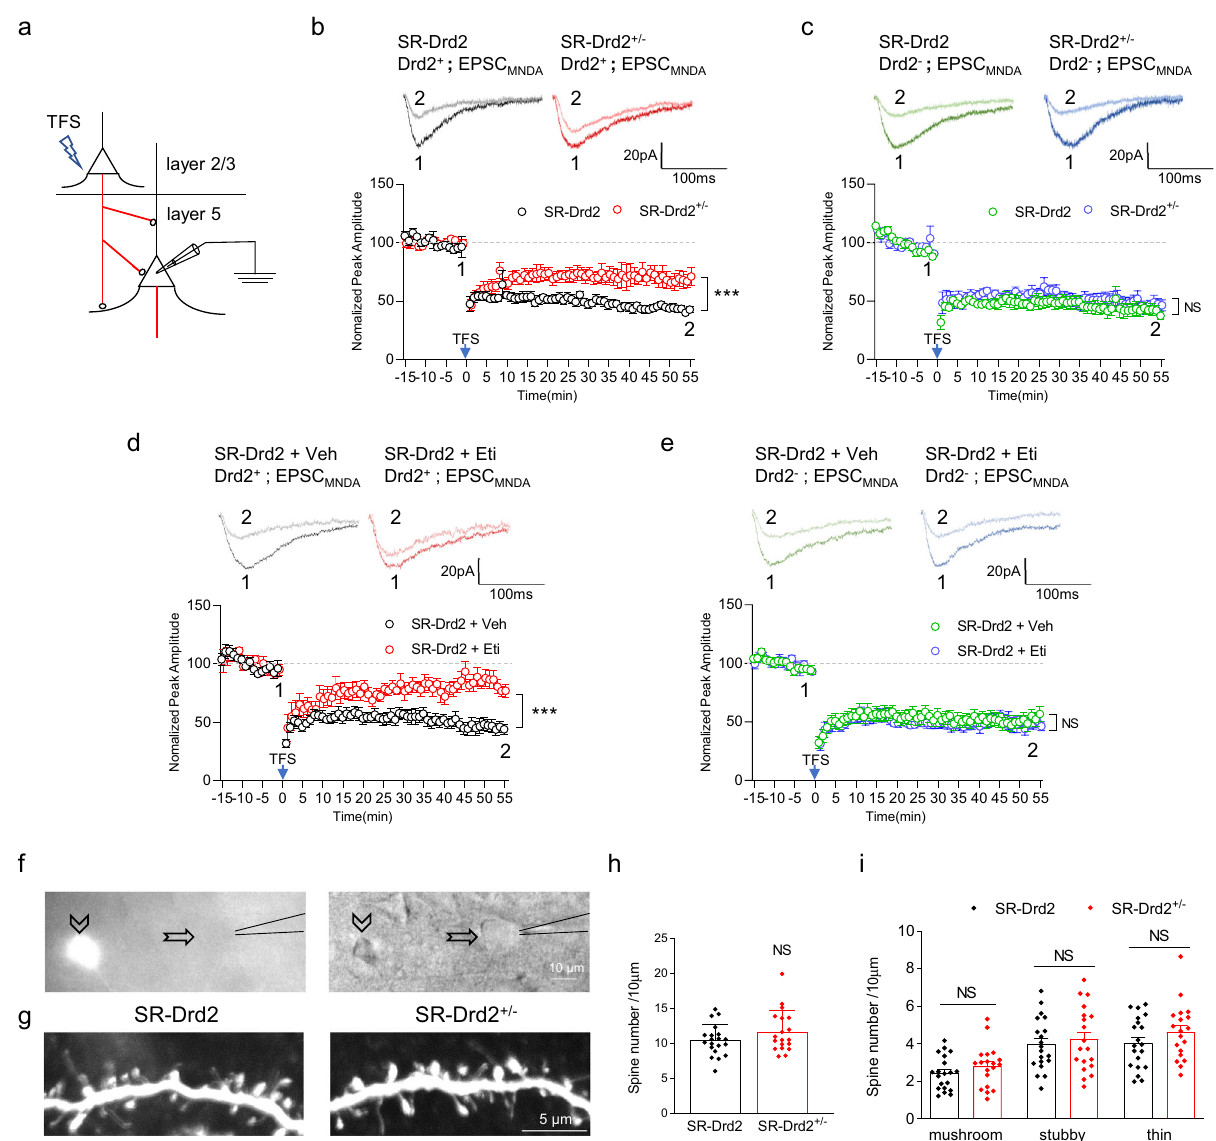
Immuno fl uorescence . The process of immuno fl uorescence on rat brain slices was performed as described in our previous studies 38 . Brie fl y, brain slices were per- meabilized with 0.5% Triton-X 100 and 5% BSA in PBS and incubated with pri- mary antibodies at 4°C overnight. The brain slices were not treated with Triton-X 100 when staining with anti- GAD67 antibodies. After washing with PBS for three times, samples were incubated with Alexa Fluor-488 goat-anti-mouse secondary antibodies (A11029; 1:500, Thermo Fisher) or Alexa Fluor-647 goat-anti-rabbit secondary antibodies (A21244; 1:500, Thermo Fisher) for 1h at room temperature. Samples were mounted with Vectashield mounting medium (Vector Labs) and images were taken by Leica TCS SP8 confocal microscope. Details of the imaging: Objective: ×20 (oil); Numerical Aperture: 0.75; The pixel sizes in microns for x-y are 0.568; image size: 1024 ×1024 px; zoom: 1×; line averaging: 1; acquisition rate: 400 Hz. The following primary antibodies were used: rabbit anti-NeuN (1:500, Abcam, ab177487), and mouse anti-GAD67 (1:300, Millipore, MAB5406). Unbiased stereology TissueFAX Plus ST (Tissue Gnostics, Vienna, Austria) 38 was applied to count tdTomato- positive and NeuN-positive cells in brain slices. The detailed methods for cell number counting is available on the website (https://tissuegnostics.com/products/ single-cell-analysis/tissuequest). The bounds of rat ACC were de fi ned following the previous publication 73 . Western blot . Homogenates of ACC were prepared in RIPA buffer containing 50mM Tris – HCl, pH 7.4, 150 mM NaCl, 2 mM EDTA, 1% sodium deoxycholate, 100 °C water bath for 10 min before western blot. Homogenates were resolved